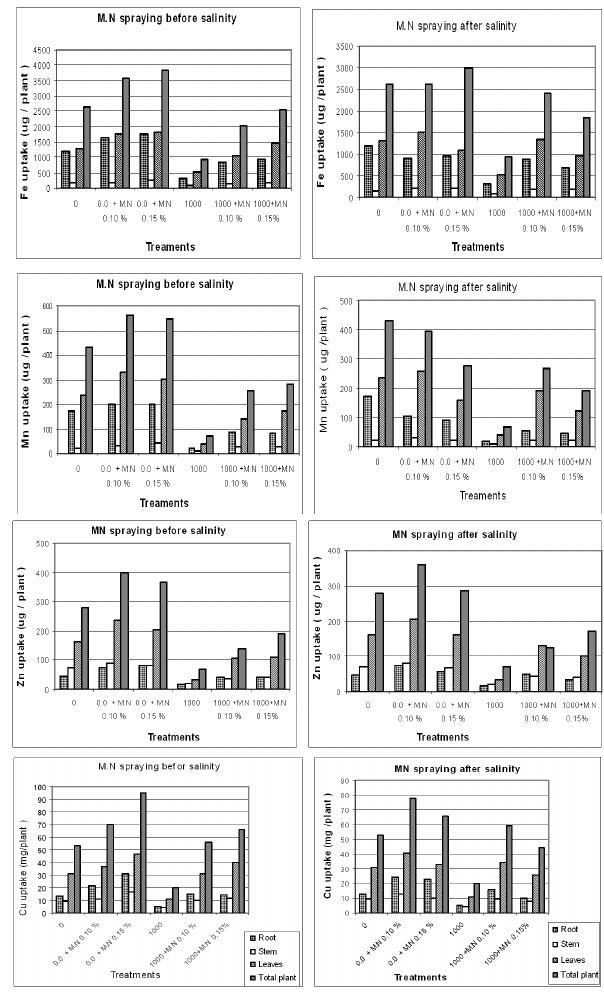
Fig. 5. Effect of micronutrients spraying before and after sa- linity treatments on Fe, Mn, Zn and Cu uptake (ug/plant) of faba bean plant; 0 = without salinity; 1000=1000 ppm NaCl;